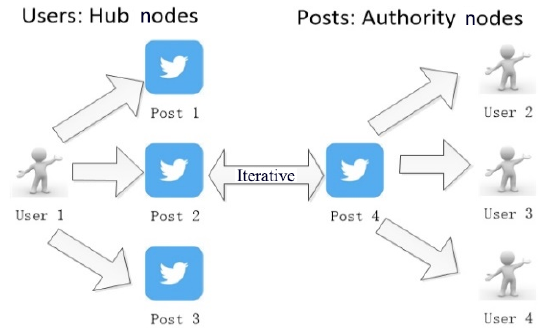
Fig. 2 Schematic diagram of the iterative process of the relationship evaluation